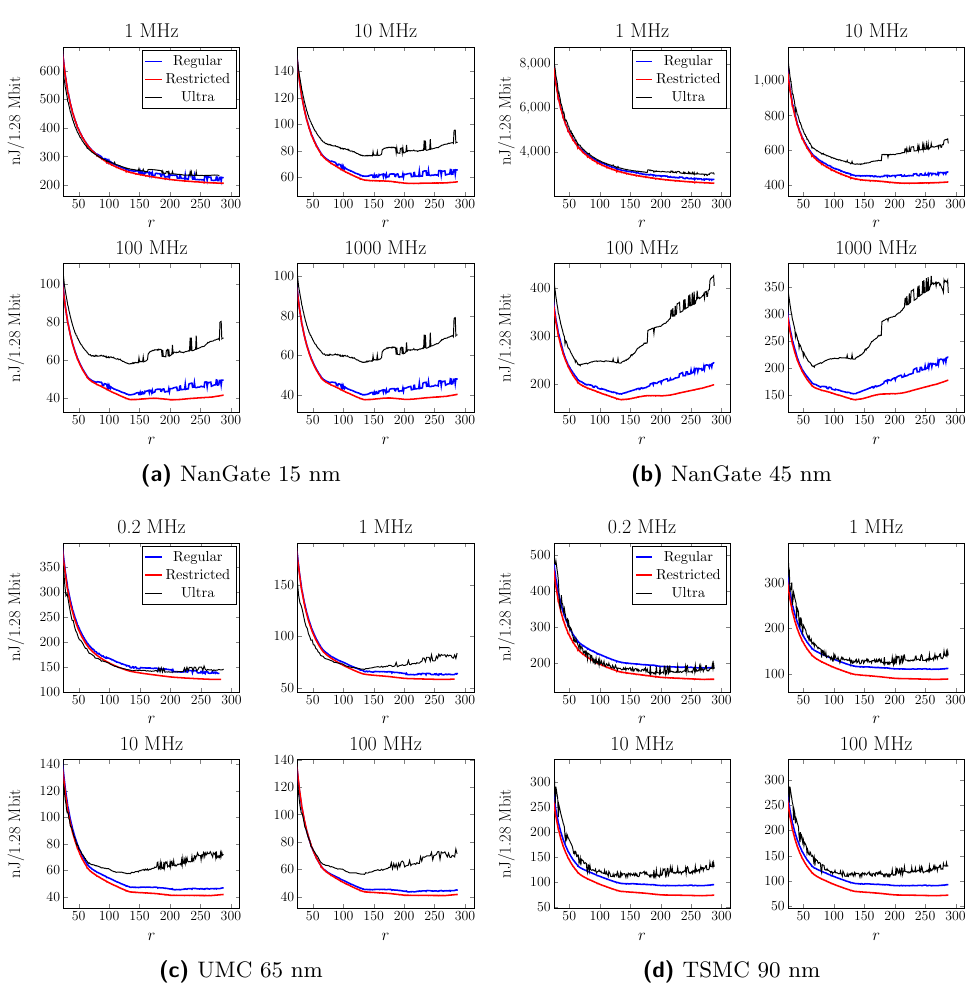
Figure 2: Trivium energy measurements for the three synthesis settings for different frequencies and libraries. Note that energy graphs are noisier for the regular/ultra modes which indicates that the synthesizer chooses different mapping strategies for varying r .